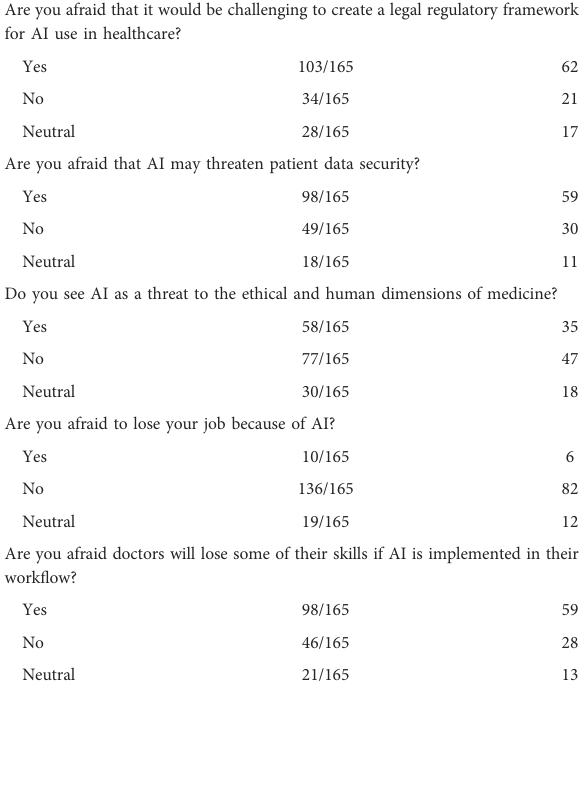
TABLE 3 Survey responses: practices regarding AI.